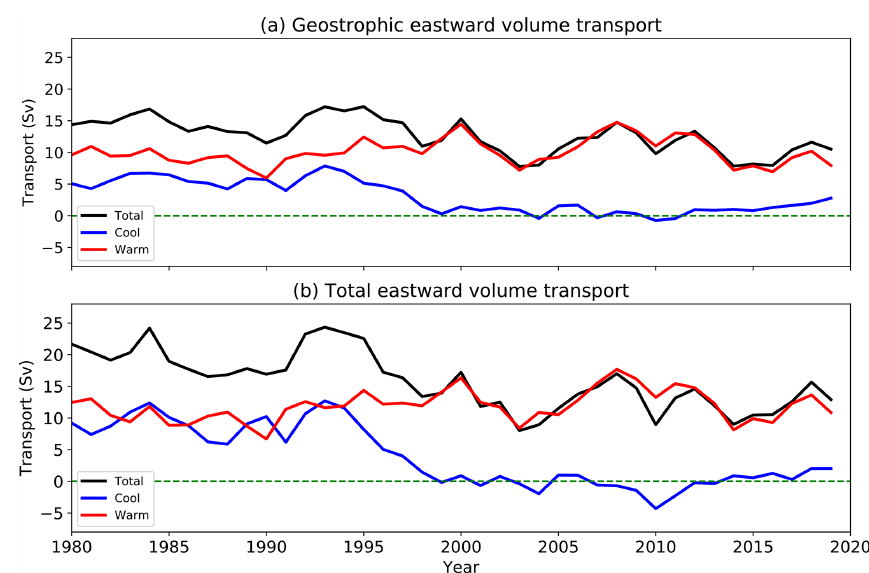
Figure 5. Eastward volume transport time series (annual means) from the GODAS dataset: (a) geostrophic and (b) total at 30 ◦ W , between 45.2 and 60.2 ◦ N, and in the upper 1000m. “Cool” is defined here as temperatures < 11 ◦ C, and “warm” is ≥ 11 ◦ C.